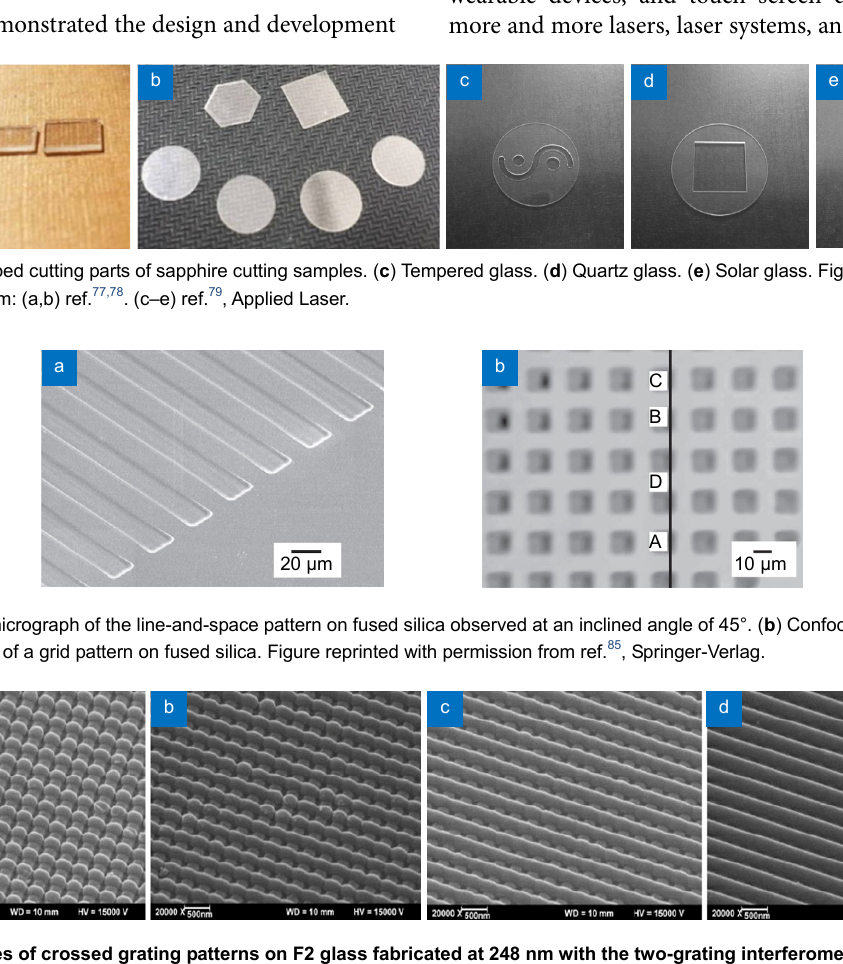
Fig. 16 | SEM images of crossed grating patterns on F2 glass fabricated at 248 nm with the two-grating interferometer with double exposure, 250 mJ/cm2 average fluence. First exposure (generating nearly vertical lines): 200 pulses . The number of pulses of the second exposure (nearly horizontal lines) is increasing from (a) to (d). Figure reprinted with permission from ref. 91 , Springer-Verlag Berlin